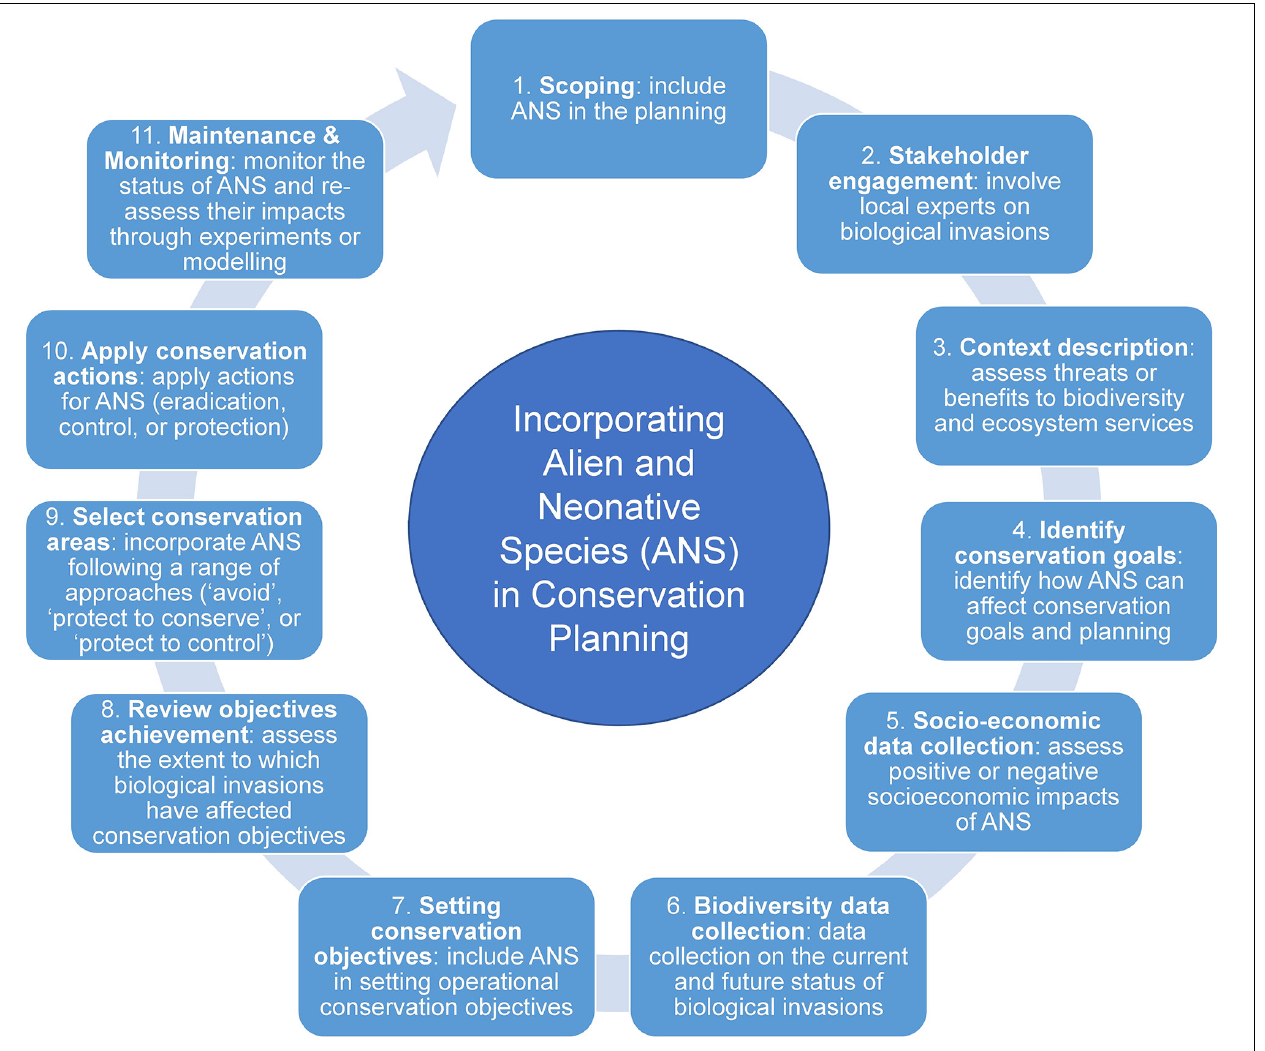
FIGURE 4 | Incorporating biological invasions in the 11-step process proposed by Pressey and Bottrill (2009). Short titles of the original steps are given in bold, followed by our proposed inclusion of Alien and Neonative Species (ANS) at each step. Adapted from Maˇci´c et al.